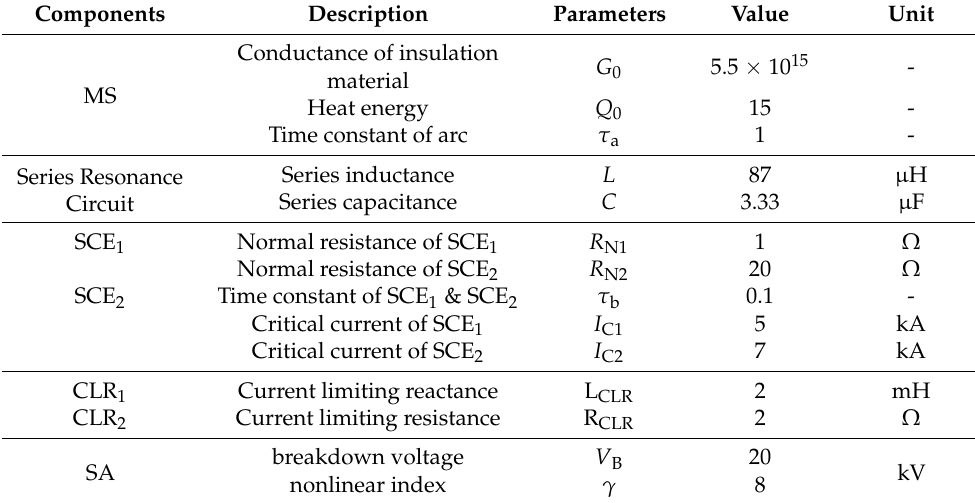
Table 2. Design Parameters of Components Comprising Hybrid DCCB using Double